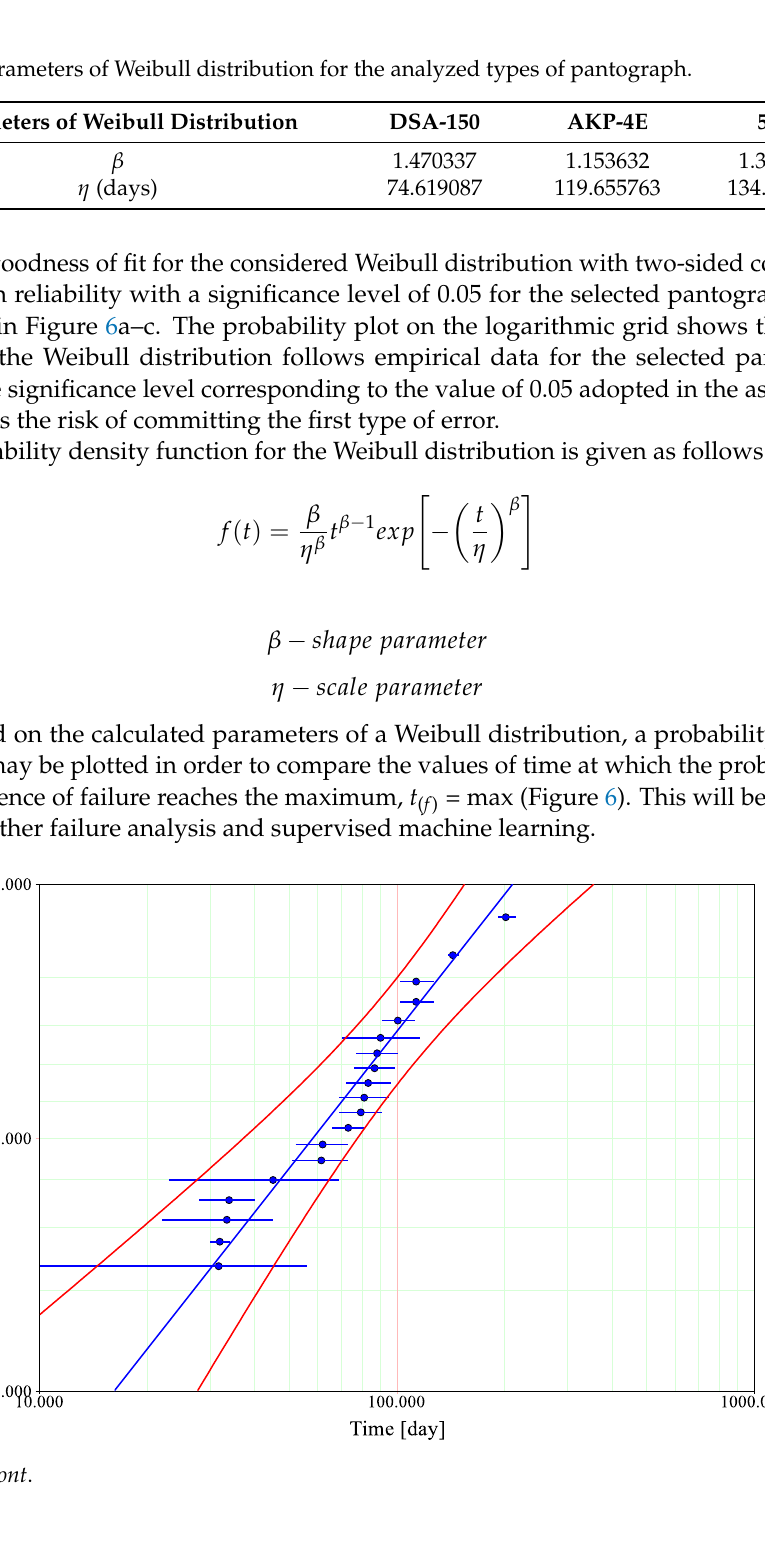
Table 3. Parameters of Weibull distribution for the analyzed types of pantograph.